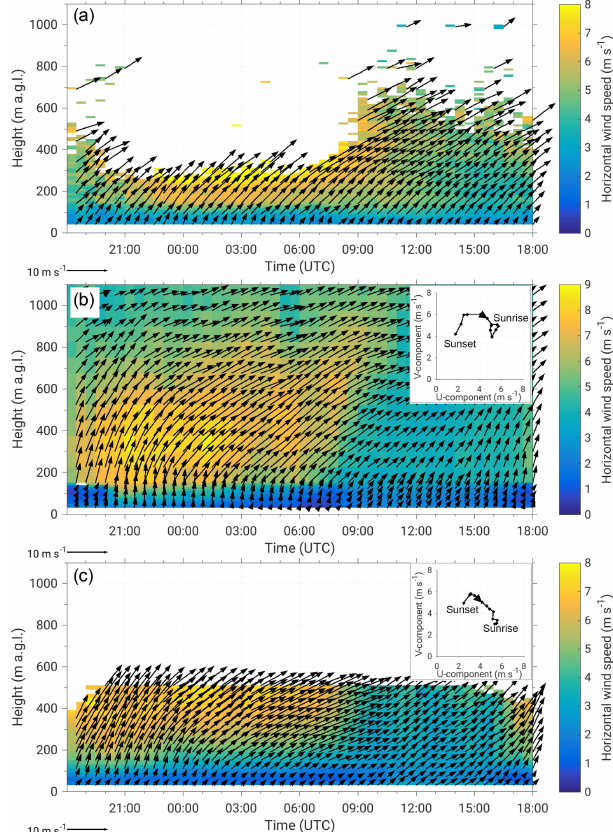
Figure 8. Median diurnal horizontal wind speed (colour coded) and horizontal wind vectors (arrows) for Kumasi (a) , Savè (b) and Ile- Ife (c) . Additionally, in (b) and (c) the hodograph from 18:00UTC (approx. sunset) to 06:00UTC (approx. sunrise) is shown with the wind components averaged over 1h and between 200 and